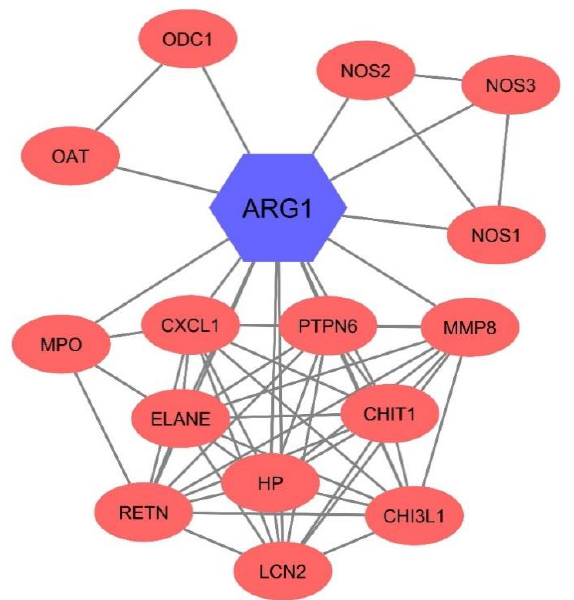
Figure 5. The protein – protein interaction (PPI) network of Arg1 . This gene might act as an interac- tor with several other genes. The PPI enrichment p -value of this network is 1.0 × 10 16